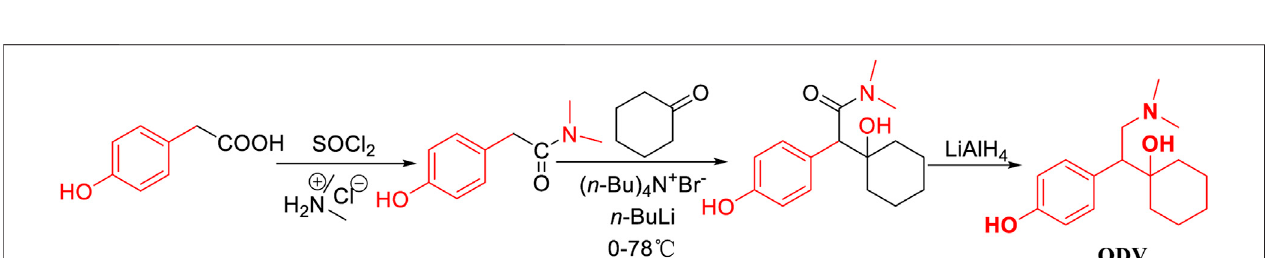
Frontiers in Chemistry |